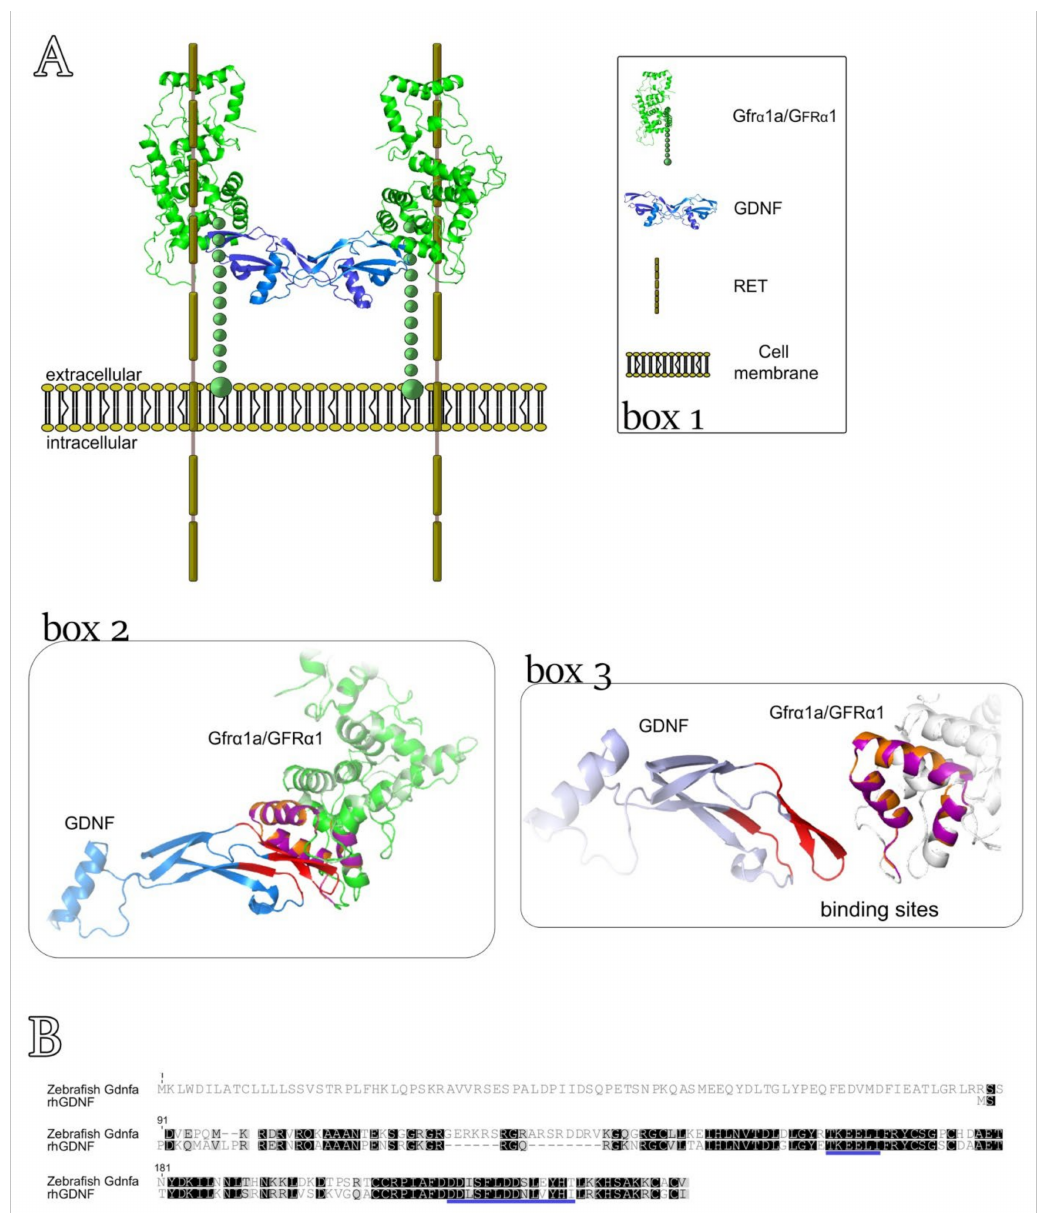
Figure 6. A 3D model to predict the interaction between rhGDNF and zebrafish Gfr α 1a. ( A ) Box 1 depicts the molecular components of the complex GDNF-GFR α 1-RET. Boxes 2 and 3 show the predictive 3D model (template 4ux8.1) in which the structural similarities between zebrafish Gfr α 1a and human GFRA1 are represented by orange and purple coloring and the identity of the structure formed at the binding sites is indicated in red. In box 2, green is used to indicate the conserved amino acid sequences between zebrafish Gfr α 1a and human GFRA1 and blue indicates the GNDF protein. In box 3, we highlighted the interaction sites between human GDNF and zebrafish Gfr α 1a/human GFRA1. ( B ) Alignment of zebrafish Gdnfa with rhGDNF. The blue lines indicate the conserved binding sites to zebrafish Gfr α 1a or human